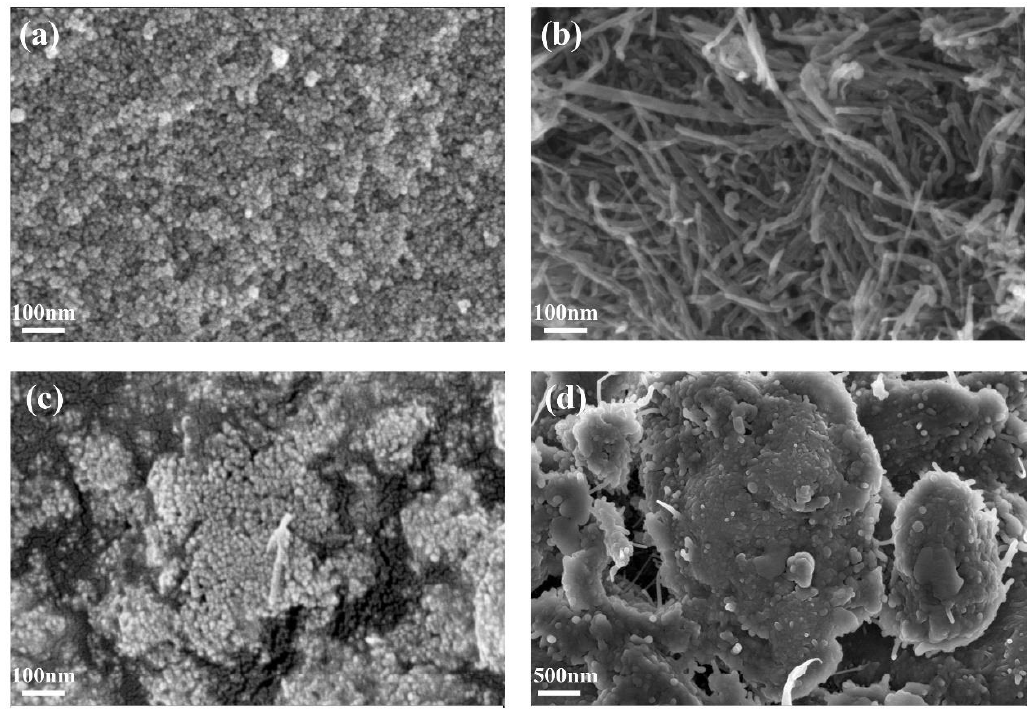
Figure 2. Scanning electron microscope (SEM) images of the ZrO 2 ( a ), CS-MWCNTs ( b ) and ZrO 2 -CS-MWCNTs composites ( c , d ).